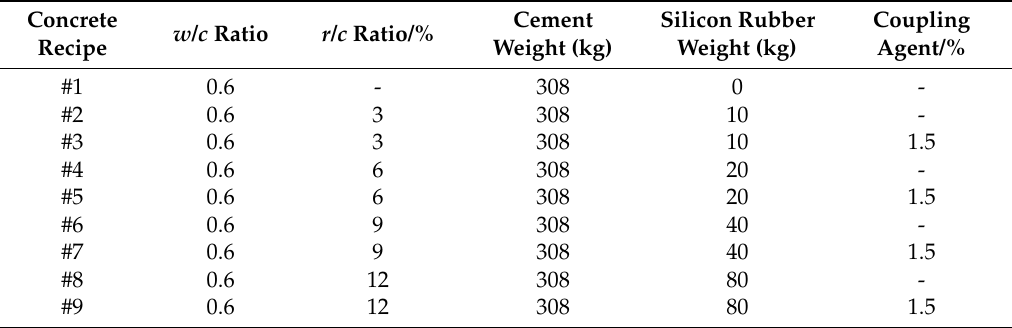
Figure 1. ( a ) KH570 coupling agent; ( b ) Rubber particle coupling process; ( c ) Coupled rubber particles. Table 1. The recipe for high damping concrete.